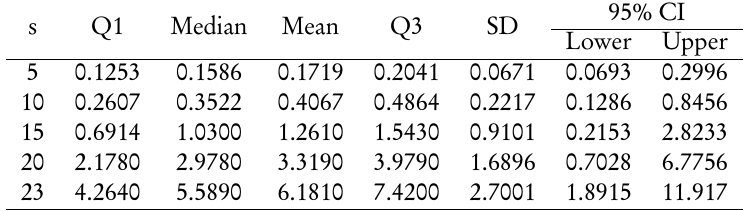
Sample based two-sample predictive posterior characteristics for the complete real data